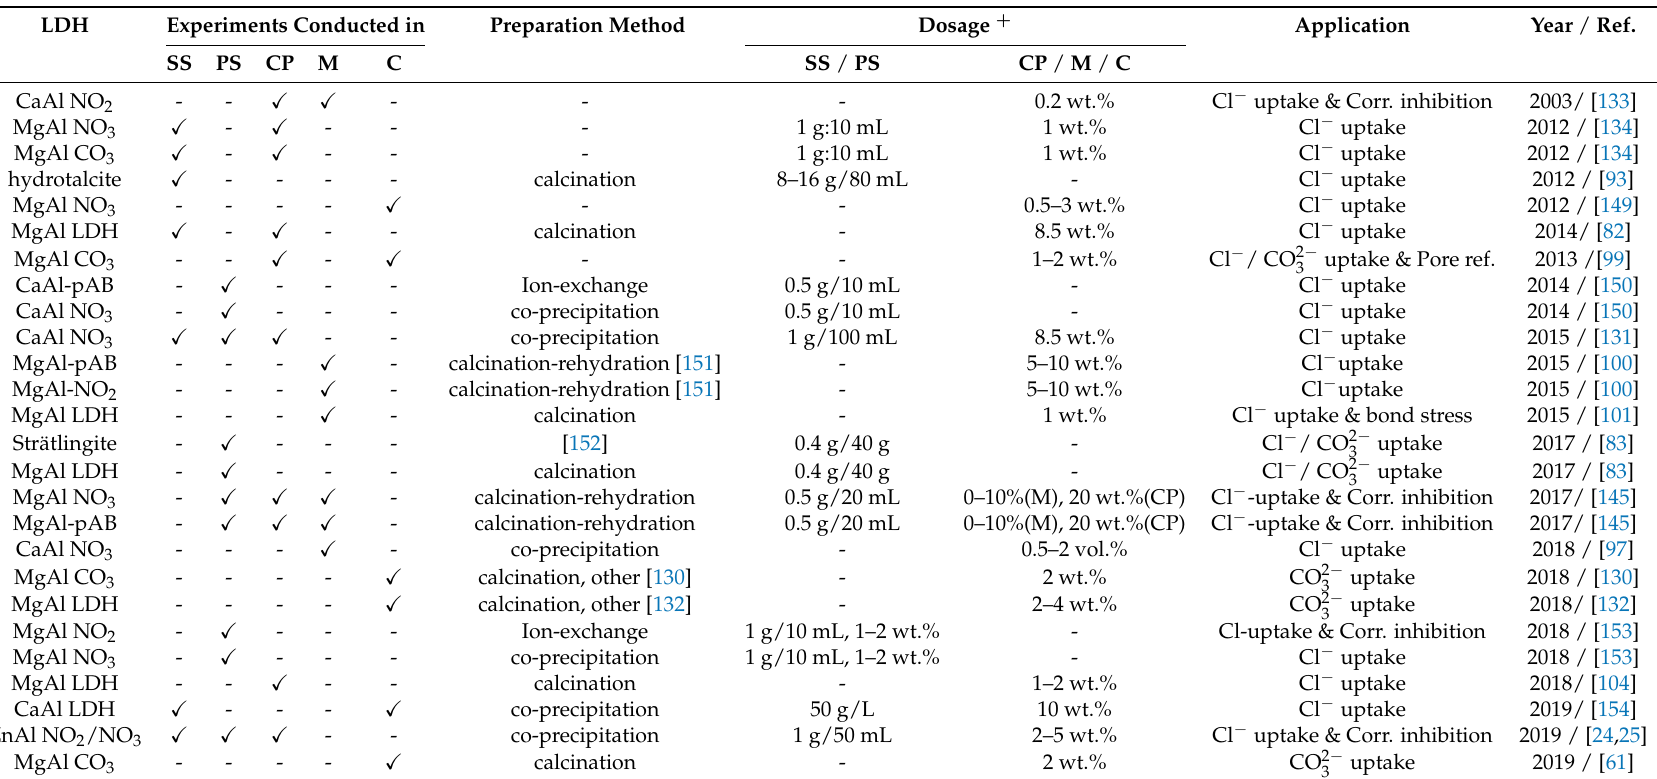
Table 2. Reported LDH types and their application in the literature together with preparation and experimental details. Abbreviations are mentioned in the end of the text. SS: Salt solution; PS: Pore solution; CP: Cement Paste; M: Mortar; C: